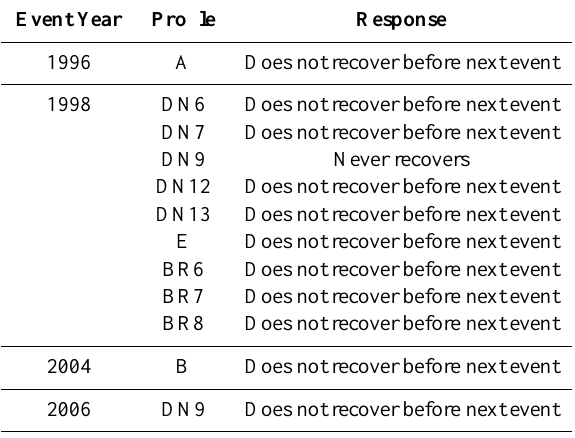
Table 5. Average volume recovery